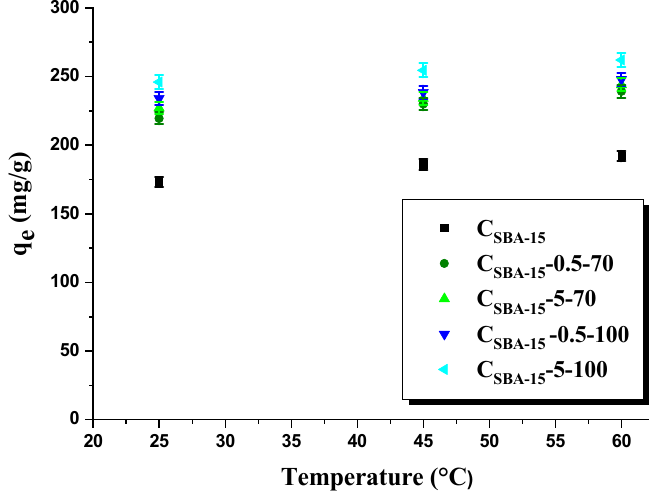
Figure 5. Zeta potential curves vs. pH for C SBA-15 , C SBA-15 -5-70, and C SBA-15 -5-100 mesoporous carbons before dye adsorption ( A ) and for C SBA-15 and C SBA-15 -5-100 after adsorption of rhodamine B ( B ).